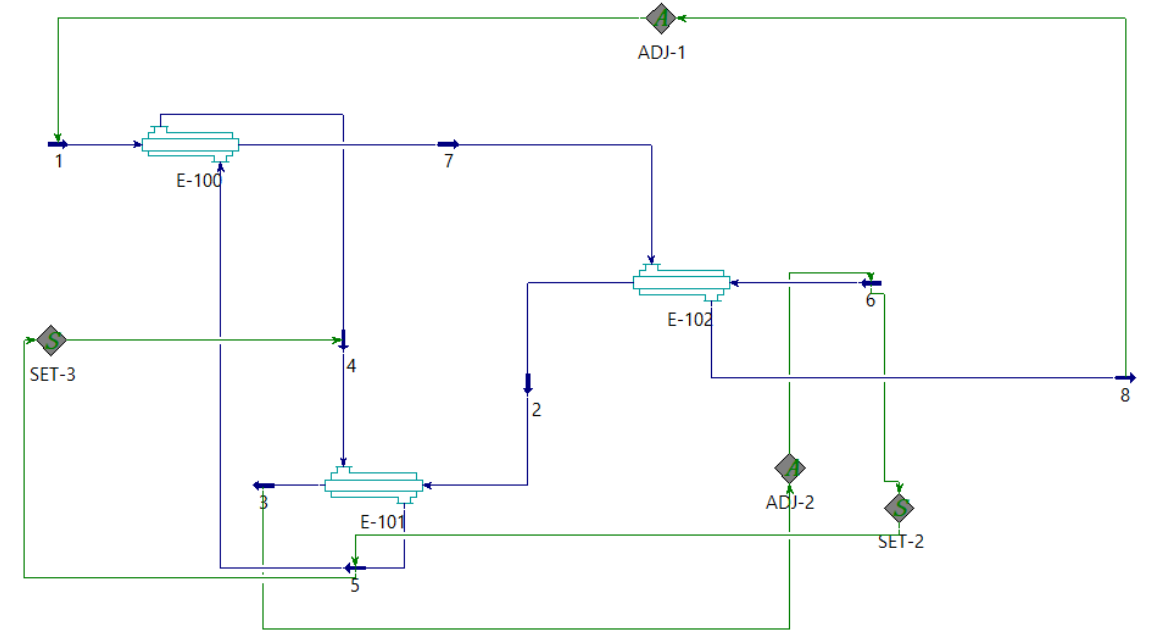
Figure 2. Simulation of the IFV heat transfer process.